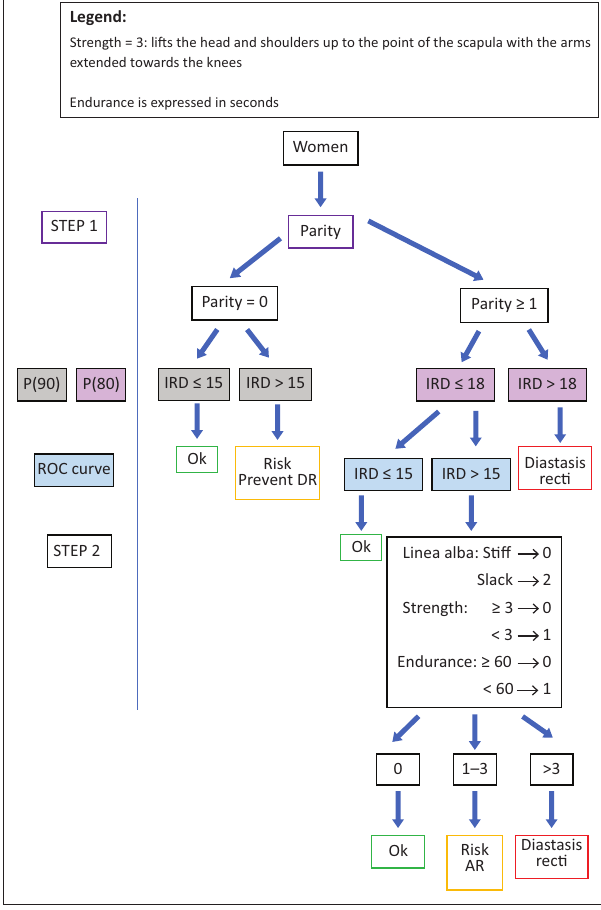
FIGURE 3: Decision tree for diastasis recti diagnosis and decision for abdominal rehabilitation treatment considering the interrecti distance measured at 5 cm above the umbilicus in a head lift